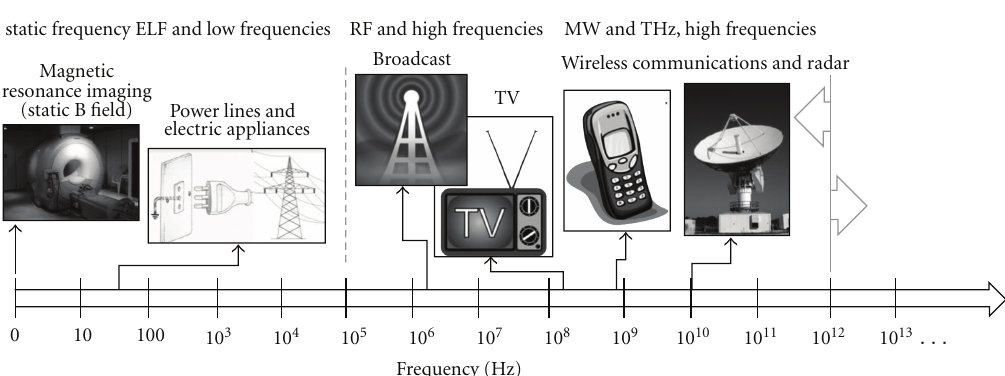
Figure 1: The whole electromagnetic spectrum, with partition between nonionizing and ionizing radiations, is reported. Main filed sources at the di ff erent frequencies are also